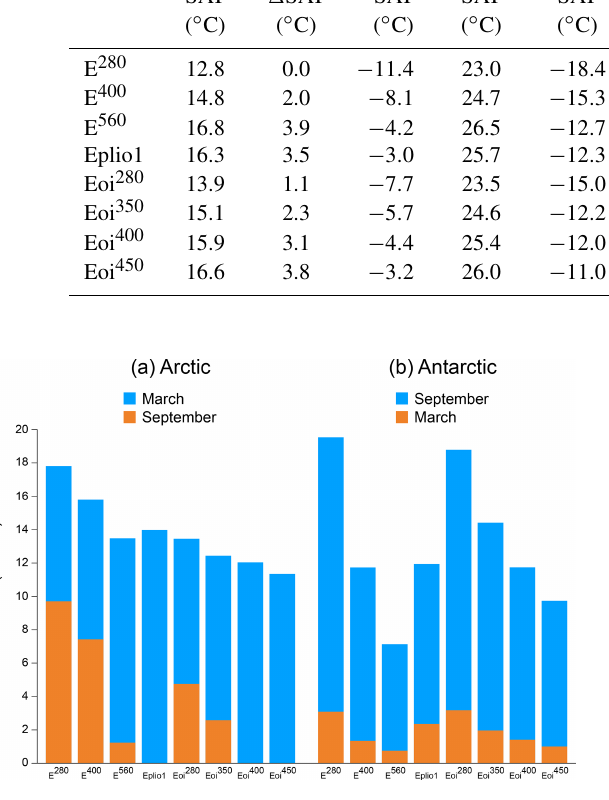
Figure 8. Total surface area of sea ice in each polar region